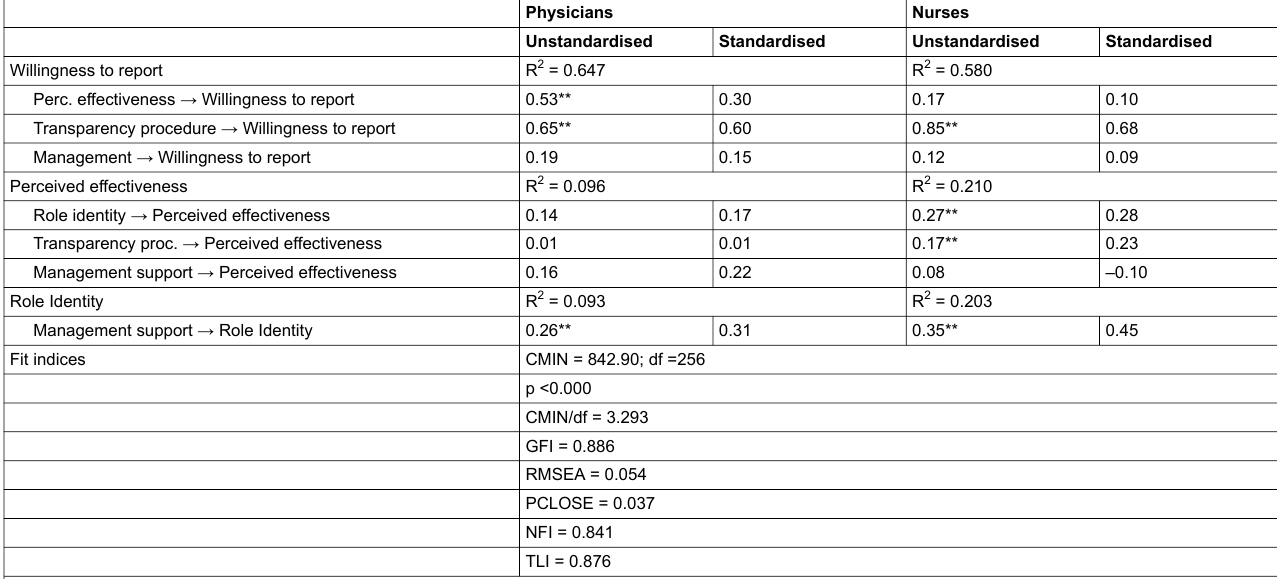
Table 9: Path coefficients and general fit indices of the multigroup analysis: professional differences.